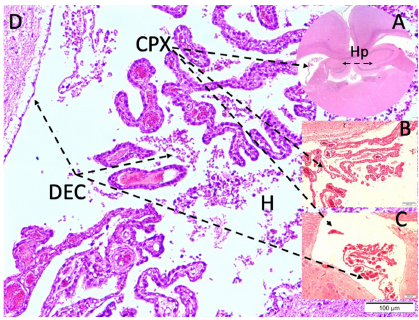
Figure 1. In the control group, the choroid plexus (CPX) and hippocampus localization in the lateral ventricle is observed. Mild degeneration in the CPX is observed in the sham group in a ventricle filled with degenerated ependymal cells, and blood cells are more atrophic and have lost their ciliary appendages in the study group.